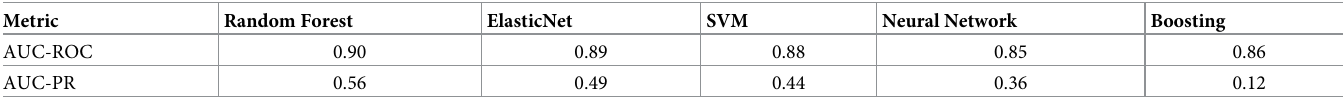
Table 3. The area under the curve (AUC) for ROC and PR of Random Forest, ElasticNet, Support Vector Machine (SVM), Neural Network and Boosting, all with top 50 tokens. They are presented in the decreasing order of AUC-PR.